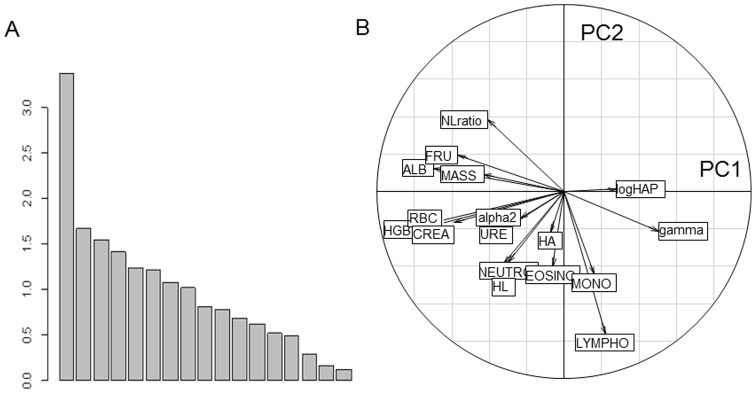
Body condition and immunocompetence.Principal Component Analysis for metabolic and immune parameters in two contrasting populations of roe deer in France. A: decomposition of variance among principal components; B: correlation circle showing the projection of all variables on principal components 1 x axis) and 2 (y-axis). See text for definition of variables.